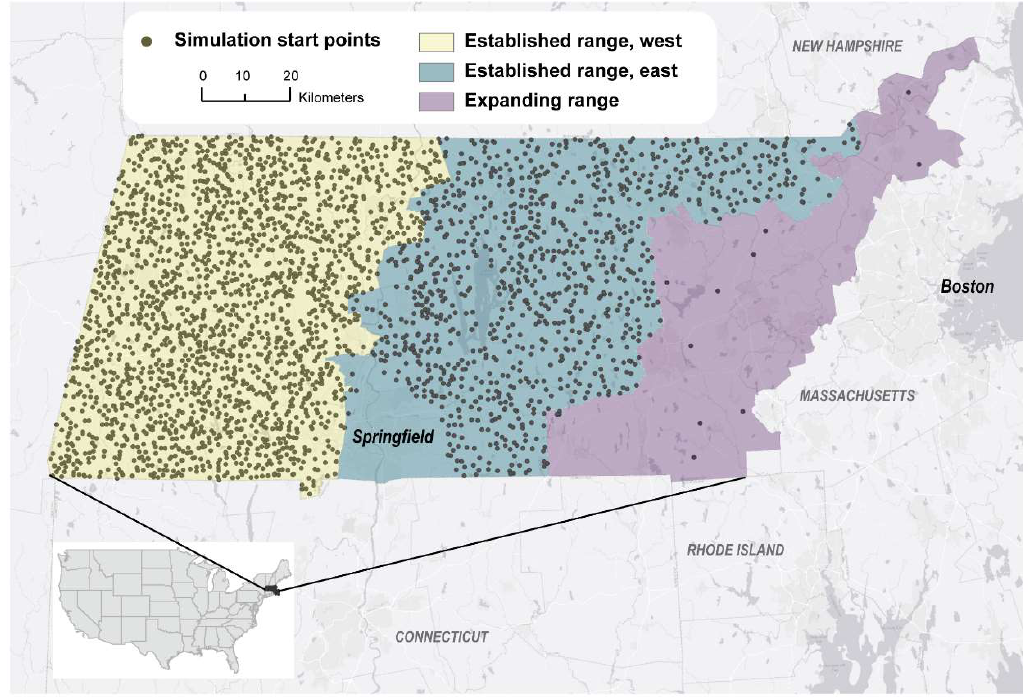
Figure 1. Black bear range in Massachusetts and distribution of start points for 3,000 simulated individuals. In the western range, 2,000 individuals were initiated, in the eastern range, 990, and in the expanding range, 10.